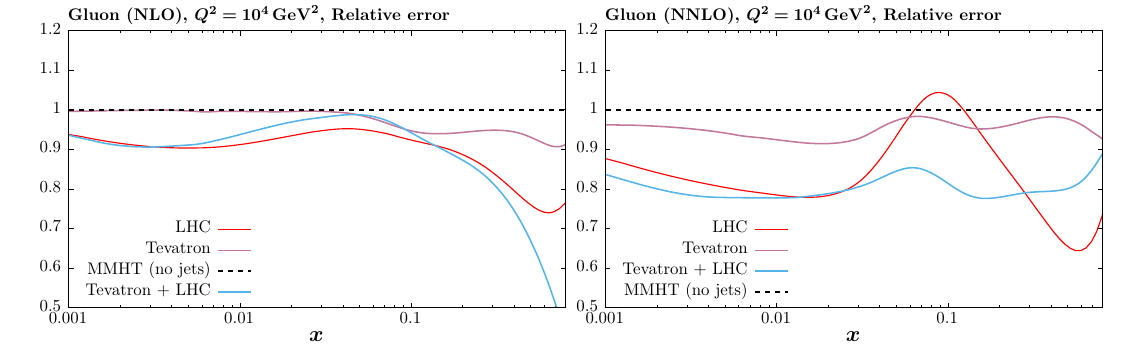
Fig. 15 The impact on the gluon PDF errors of including the LHC [23,24] and Tevatron [14,15] data in the global fit. The ratio of the 68% C.L. errors to the baseline fit is shown and the NLO (NNLO) case is shown in the left (right) figures. For the LHC case, R high and p jet ⊥ are